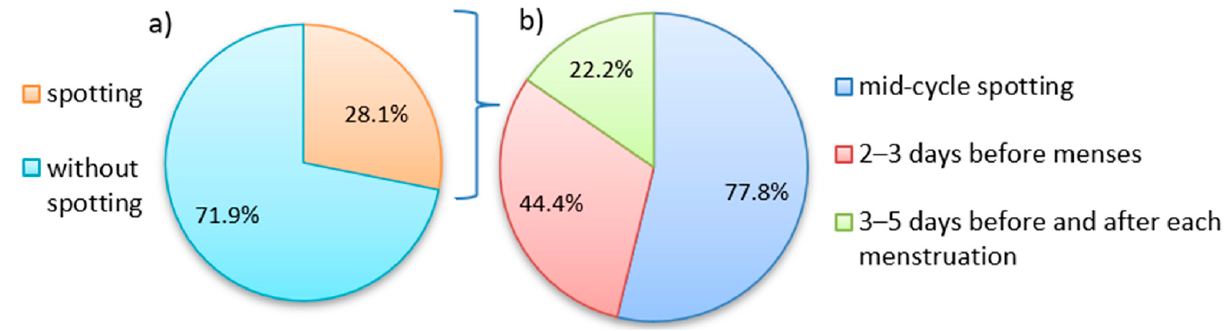
Figure 1. The structure of non-menstrual spotting in the study’s sample: ( a ) the frequency of spotting in the sample, ( b ) the structure of spotting in relation to menstrual cycle.